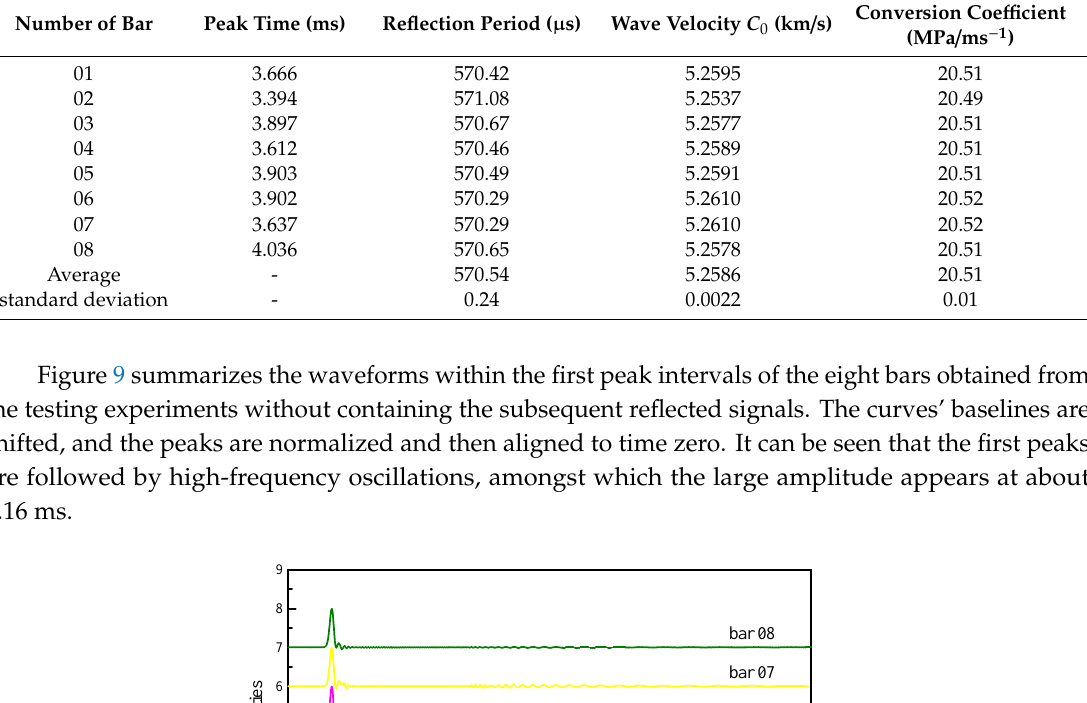
Table 3. The preliminary results of the pressure bar obtained by the testing experiment.